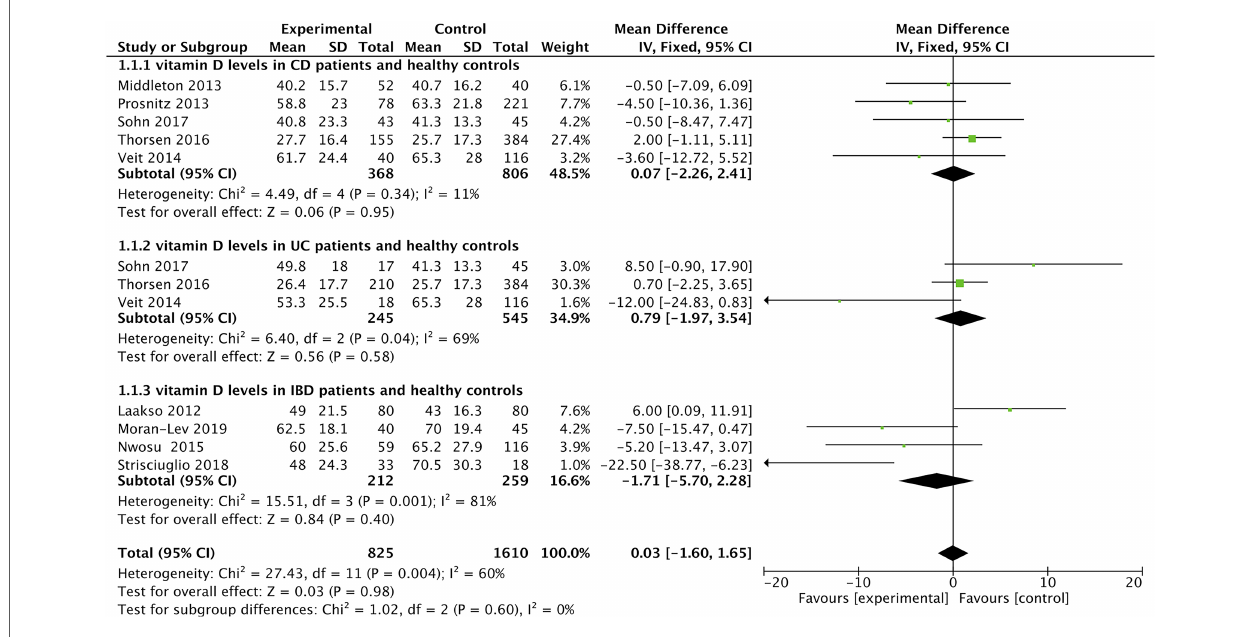
11.83 mg/L before vitamin D supplementation and 2.64 mg/L after vitamin D supplementation. The overall pooled results showed that CRP was 2.65 higher before vitamin D supplementation than after supplementation [SMD = 2.65, 95% CI = (2.26, 3.04)] ( Figure 4 ). In the forest plot, there is no intersection between the rhombus and the lin fi e, indicating that the combined results are statistically signi fi cant. In addition, in 5 articles describing IBD in remission, the proportion of patients with IBD in remission was 57.7% before vitamin D supplementation and 65.3% after vitamin D supplementation. The overall pooled results showed that patients with IBD in remission were 0.72 higher before vitamin D